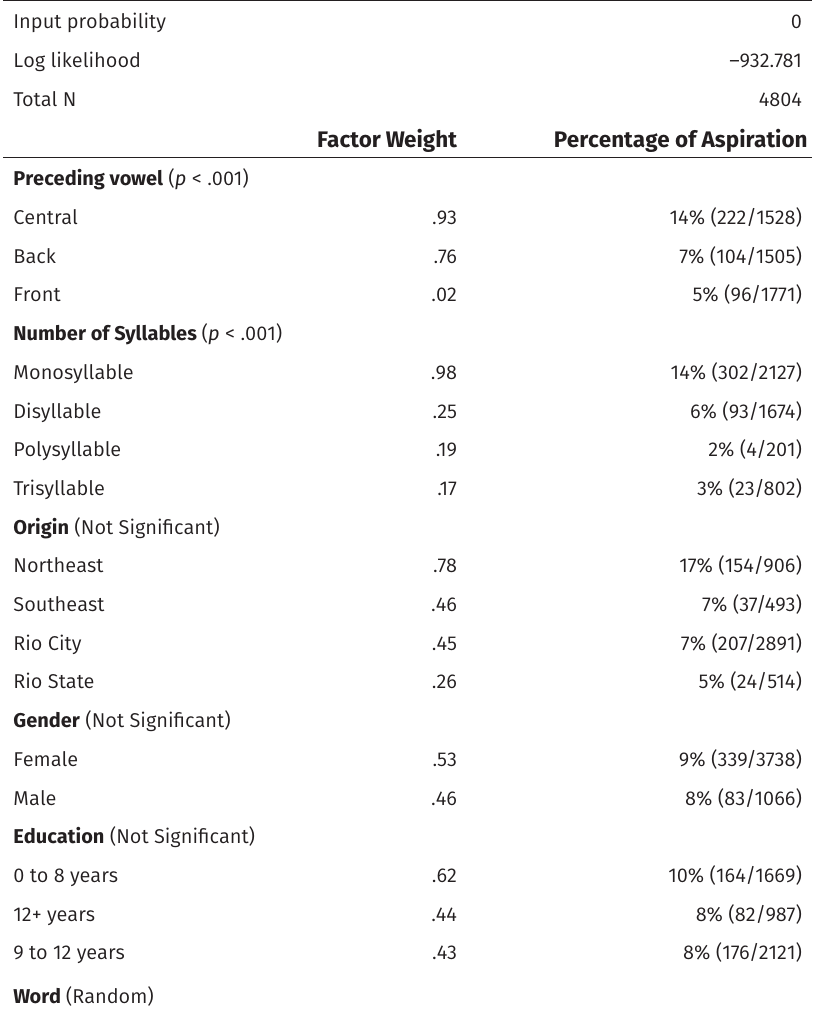
Table 1: Run 1 of the logistic regression analysis for /s/ aspiration. /S/ Aspiration (Application